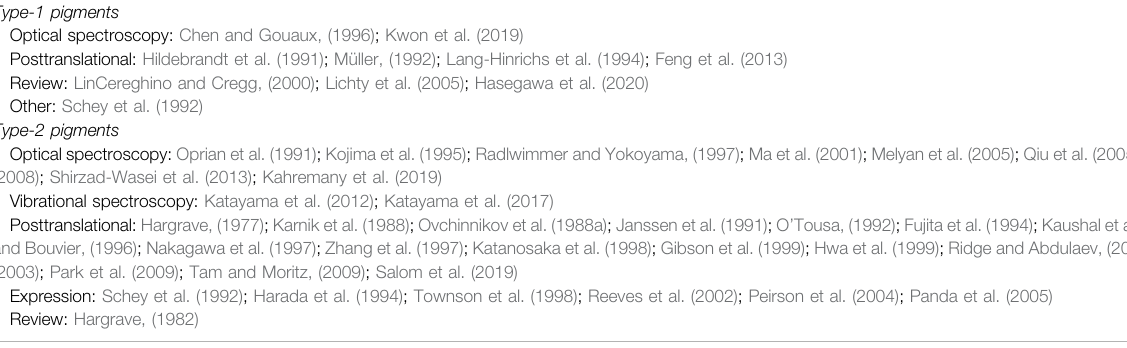
TABLE 3 | Selected additional citations for the section “ Heterelogous expression and puri fi cation ” . Type-1 pigments Optical spectroscopy: Chen and Gouaux, (1996); Kwon et al. (2019) Posttranslational: Hildebrandt et al. (1991); Müller, (1992); Lang-Hinrichs et al. (1994); Feng et al. (2013) Review: LinCereghino and Cregg, (2000); Lichty et al. (2005); Hasegawa et al. (2020) Other: Schey et al. (1992) Type-2 pigments Optical spectroscopy: Oprian et al. (1991); Kojima et al. (1995); Radlwimmer and Yokoyama, (1997); Ma et al. (2001); Melyan et al. (2005); Qiu et al. (2005); Giesbers et al. (2008); Shirzad-Wasei et al. (2013); Kahremany et al. (2019) Vibrational spectroscopy: Katayama et al. (2012); Katayama et al. (2017) Posttranslational: Hargrave, (1977); Karnik et al. (1988); Ovchinnikov et al. (1988a); Janssen et al. (1991); O ’ Tousa, (1992); Fujita et al. (1994); Kaushal et al. (1994); Morello and Bouvier, (1996); Nakagawa et al. (1997); Zhang et al. (1997); Katanosaka et al. (1998); Gibson et al. (1999); Hwa et al. (1999); Ridge and Abdulaev, (2000); Maeda et al. (2003); Park et al. (2009); Tam and Moritz, (2009); Salom et al. (2019) Expression: Schey et al. (1992); Harada et al. (1994); Townson et al. (1998); Reeves et al. (2002); Peirson et al. (2004); Panda et al. (2005) Review: Hargrave,